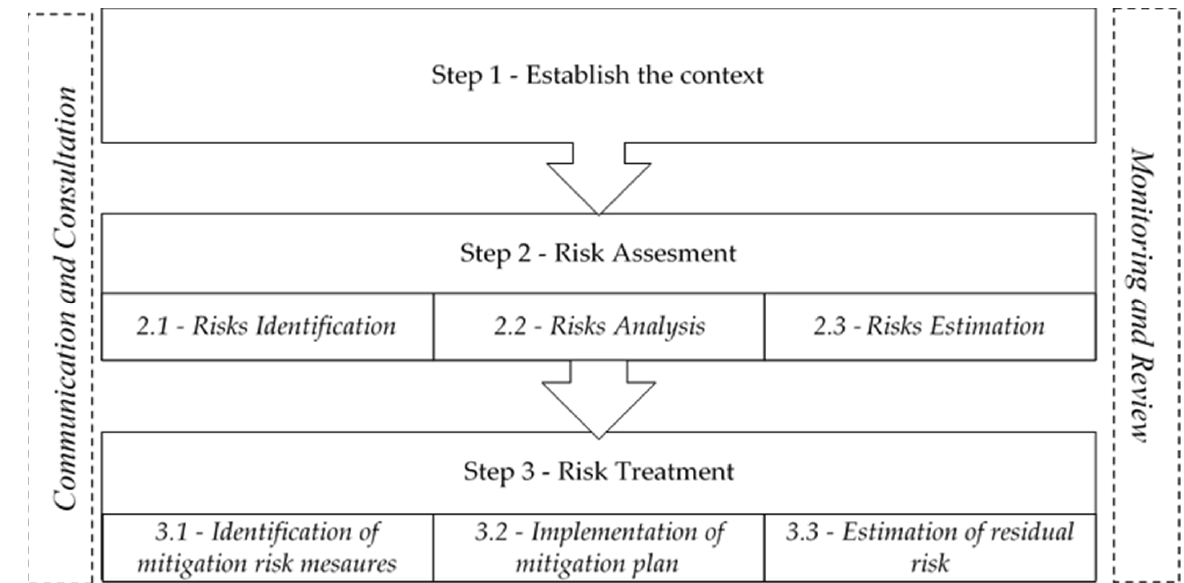
Figure 1. Risk Management Process (RMP) phases.